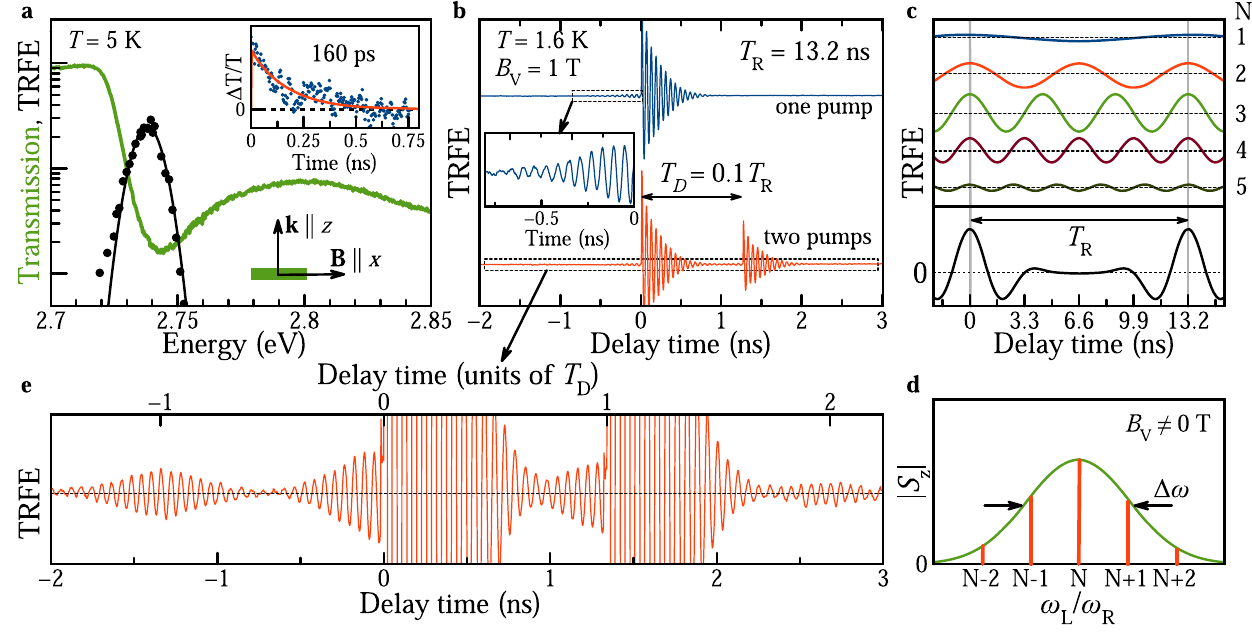
Fig. 1 | Spin mode locking in CsPb(Cl, Br) 3 NCs. a Transmission spectrum of CsPb ð Cl 0 : 56 Br 0 : 44 Þ 3 NCs (green line). Black dots show spectral pro fi le of the Faradayellipticityamplitudemeasuredatzeropump-probetimedelay fi ttedbya Gaussian function (black line). T =5 K. Inset shows time-resolved differential transmission (dots) with a monoexponential fi t (red line) providing the exciton lifetime of 160 ps. b Time-resolved Faraday ellipticity (TRFE) measured at the photon energy of 2.737 eV with 1.5 ps laser pulses. Blue curve shows data for the one-pumpprotocolwitharepetitionperiodof T R =13.2nsusingthepumppower P pu =25 mW. Inset shows zoom of signal before the arrival of the pump pulse, indicated by the box. Red curve is TRFE for the two-pump protocol ( T D =0.1 T R =1.32 ns) using the pump powers P pu,1 =25 mW and P pu,2 =13 mW. T =1.6 K and B V =1 T. c Scheme shows spins precessing at fi ve lowest PSC mode